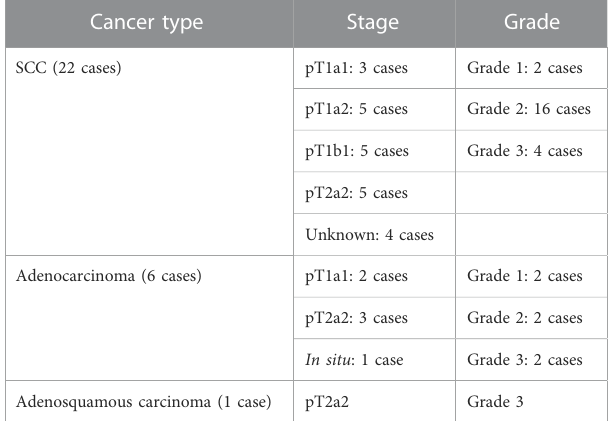
TABLE 1 Staging and grades of the cancer cases per cancer type. None of the cases was reported as metastatic. Cancer